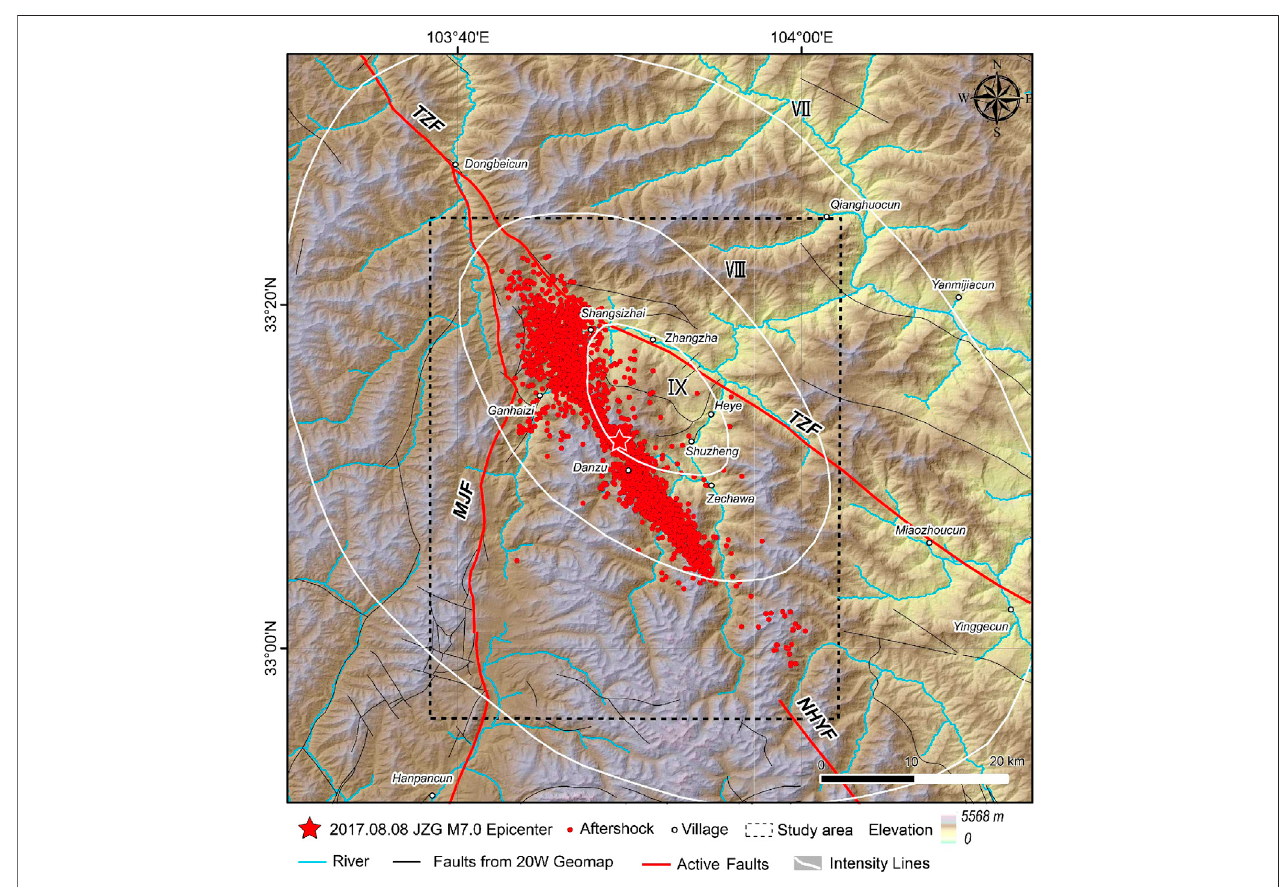
FIGURE 1 | Active tectonic map of the 2017 Jiuzhaigou Earthquake. MJF: Minjiang Fault, NHYF: North Huya Fault, TZF: Tazang Fault.